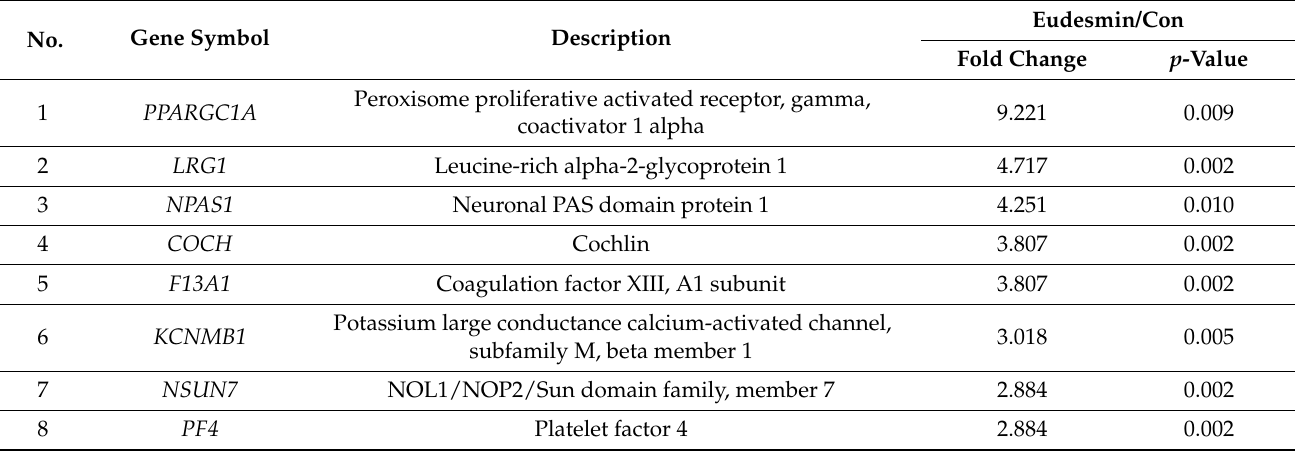
Figure 2. Enrichment of PRC2 target genes in eudesmin-mediated upregulated genes. ( A ) Heatmap of differentially expressed genes by eudesmin treatment (upregulated: 44 genes, downregulated: 46 genes). ( B ) Analysis of upregulated genes by eudesmin treatment with ENCODE Histone Modifications 2015 database in Enrichr. ( C ) Analysis of upregulated genes by eudesmin treatment with Epigenomics Roadmap HM ChIP-seq database in Enrichr. ( D ) Heatmap of PRC2 target genes upregulated by eudesmin (Cluster 1). Table 1. PRC2 target genes upregulated by eudesmin (Cluster 1).